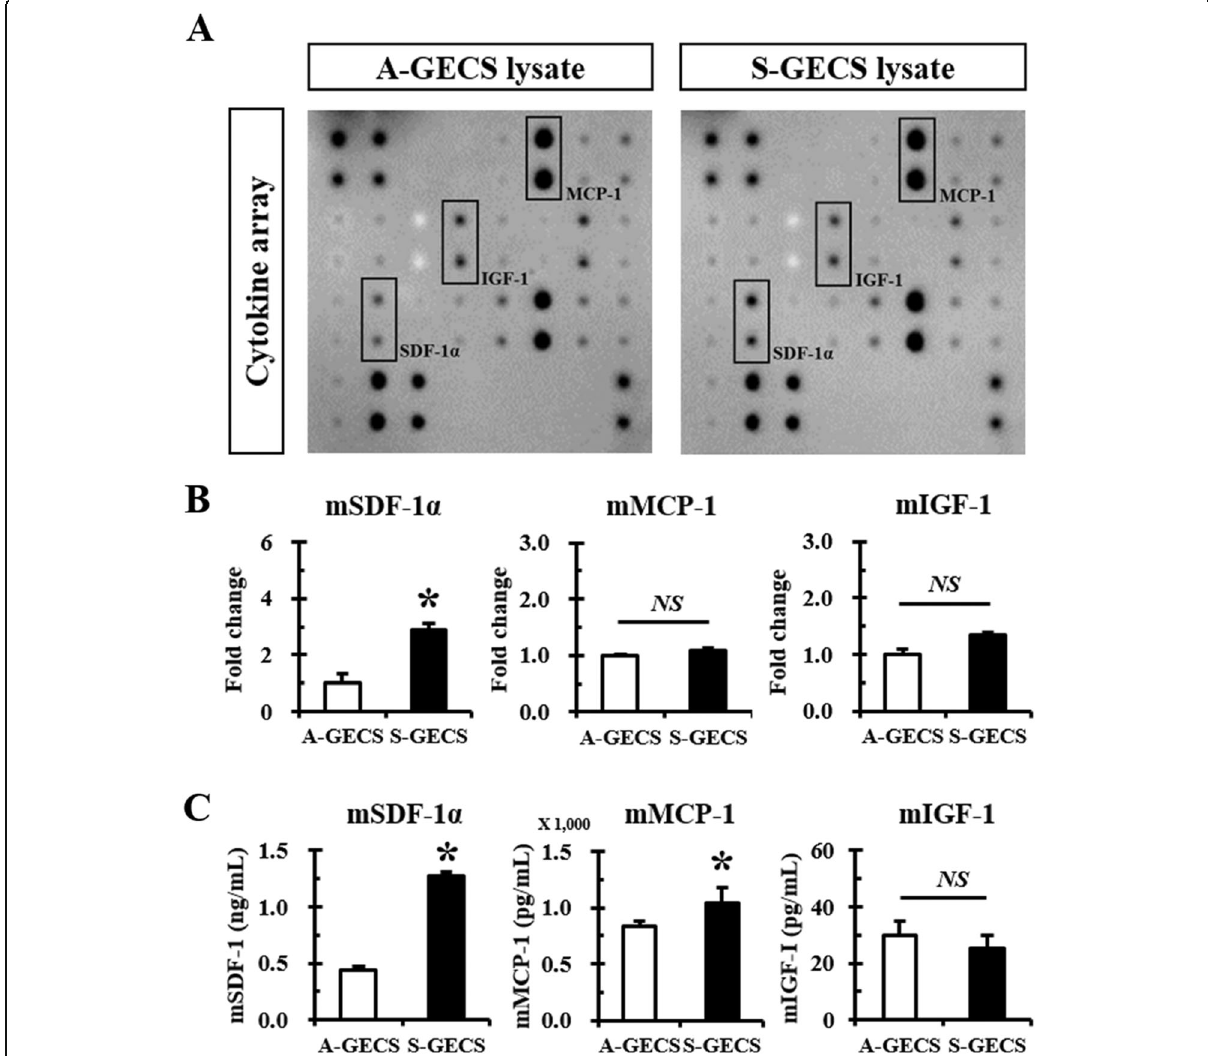
Fig. 2 Cytokines/chemokine antibody array panels of S-GECS lysates. a Representative cytokine/chemokine antibody array panel of A-GECS and S- GECS lysates. b Comparison of highly expressed SDF-1 α , MCP-1, and IGF-1 between A-GECS and S-GECS. Relative expression of cytokines and chemokines was measured by densitometry, each in triplicate. * p < 0.05 vs. A-GECS. (C) ELISA of SDF-1 α , MCP-1, and IGF-1 between A-GECS and S-GECS, each in triplicate. * p < 0.05 vs.